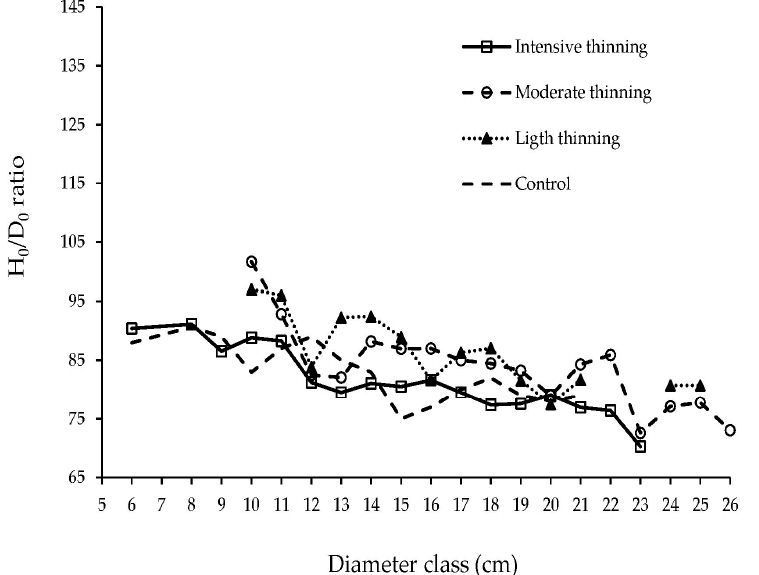
Figure 4. H o /D o ratio by diameter classes and thinning treatments in laurel stands, Ecuadorian Amazon upper basin.